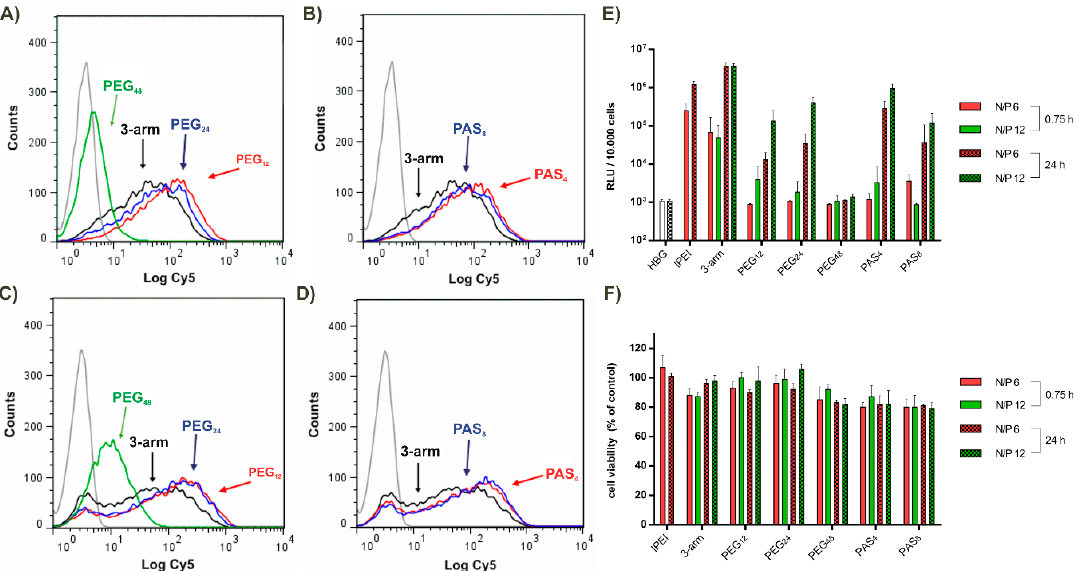
Figure 4. In ( A , B ) cellular association of polyplexes with N2a cells after 30 min incubation at 4 °C as determined by flow cytometry is plotted; In ( C , D ) cellular internalization of polyplexes after 45 min incubation at 37 °C followed by removal of extracellularly-bound polyplexes is displayed; Logarithmic X-scale in ( A – D ) represents Cy5 fluorescence of polyplexes; ( E ) Luciferase reporter gene expression in N2a cells after 0.75 h (without pattern) and after 24 h (with pattern). Transfections were performed at two different ratios: N/P = 6 (red) and N/P = 12 (green). ( F ) Cell viability assay was performed in parallel.